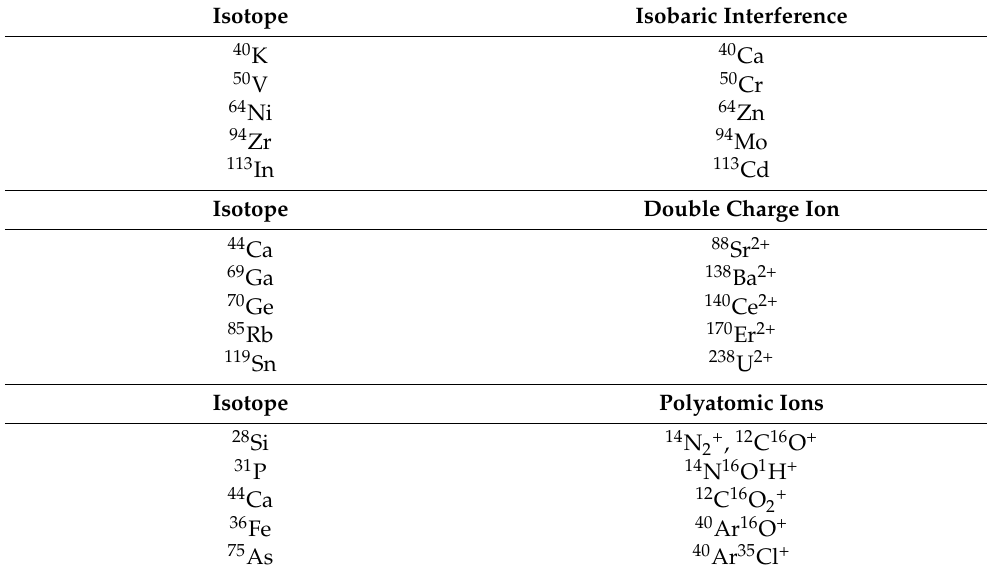
Table 1. Selected typical spectroscopic interferences. Isotope Isobaric